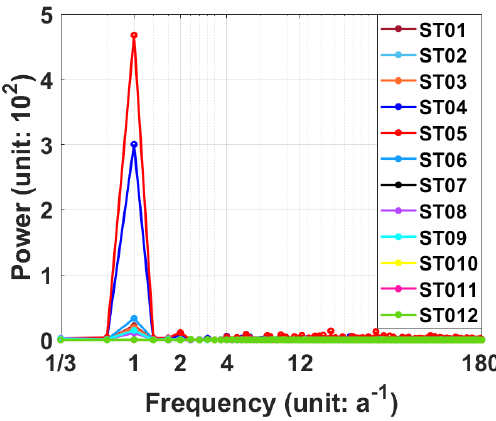
Figure 4. Temporal frequency spectrograms for ZHD biases of model SAAS D .